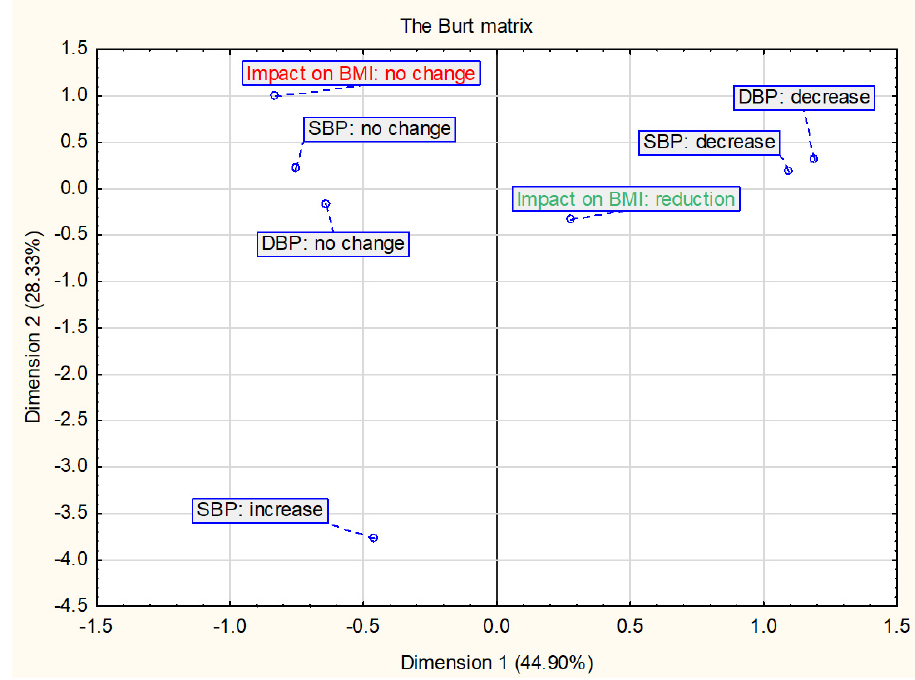
Figure 4. Presentation of the correspondence analysis results defining the relationship between the changes in BMI and/or BMI z-score and changes in blood pressure ( n = 20).